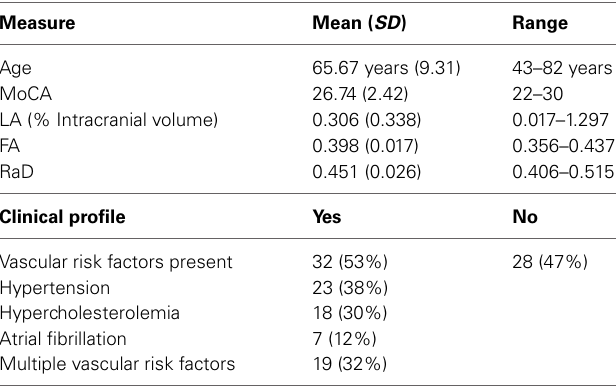
Table 1 | Mean (standard deviation) for age, Montreal Cognitive Assessment (MoCA), leukoaraiosis severity (LA), mean fractional anisotropy (FA), and radial diffusivity (RaD) as well as clinical profile of